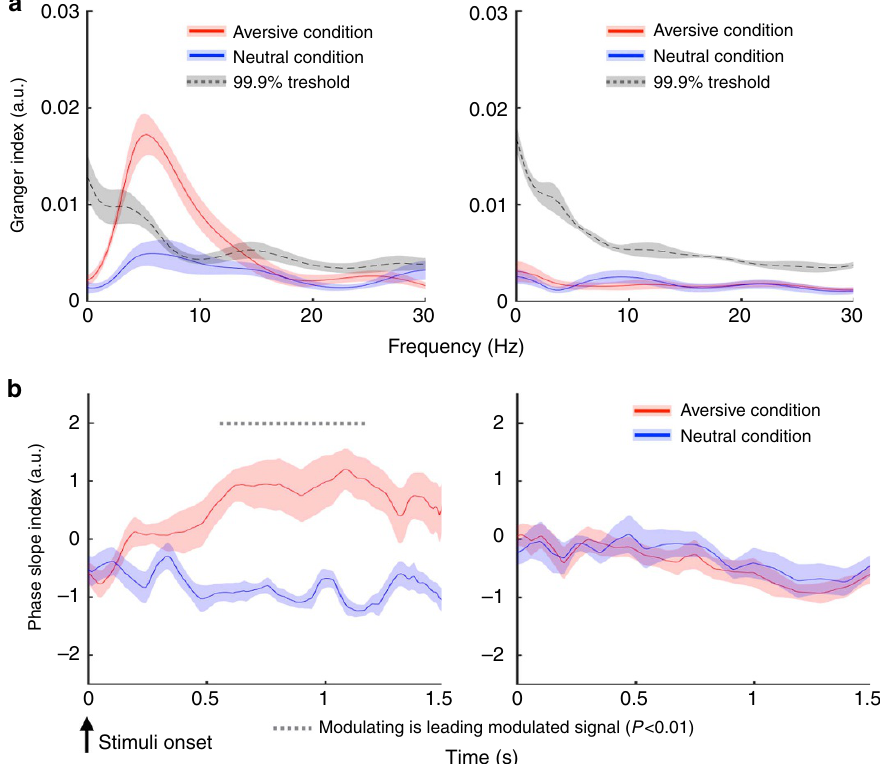
Figure 4 | Granger causality analyses and PSI. ( a ) Granger causality analyses demonstrated consistently stronger influence for the amygdala-to- hippocampus direction (top left) than for the hippocampus-to-amygdala direction (top right) when contrasting the aversive to the neutral condition. The red and blue solid lines represent the real data from aversive and neutral conditions ± s.e.m., respectively. Dotted lines denote 99% confidence intervals for the null distribution. ( b ) PSI between the aversive and the neutral conditions calculated point-by-point across time using the low-frequency signal from the modulating channel (coloured in red) and high gamma signal from the modulated channel (coloured in blue). Dotted lines above the graph denote significant differences between the two signals (all P o 0.01, permutation test), showing that low-frequency activity from amygdala precedes hippocampus gamma for the majority of the stimuli duration (bottom left). The PSI did not show a directional influence from the hippocampus to amygdala (bottom